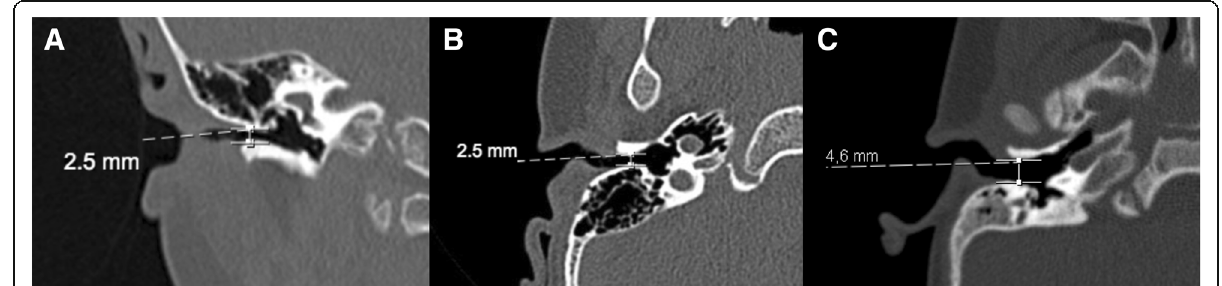
Fig. 5 Coronal ( a ) and axial ( b ) reconstruction of a temporal bone CT of a 2-year-old boy with Down syndrome, at the level of the mesotympanum, depicting a right stenotic external auditory canal (less than 4mm in diameter as defined by Cole and Jahrsdoerfer, 2009). Axial reconstruction ( c ) of a temporal bone CT of a normal 2-year-old boy for comparison. Measurement is done in the bony component of the external auditory canal at the most stenotic point